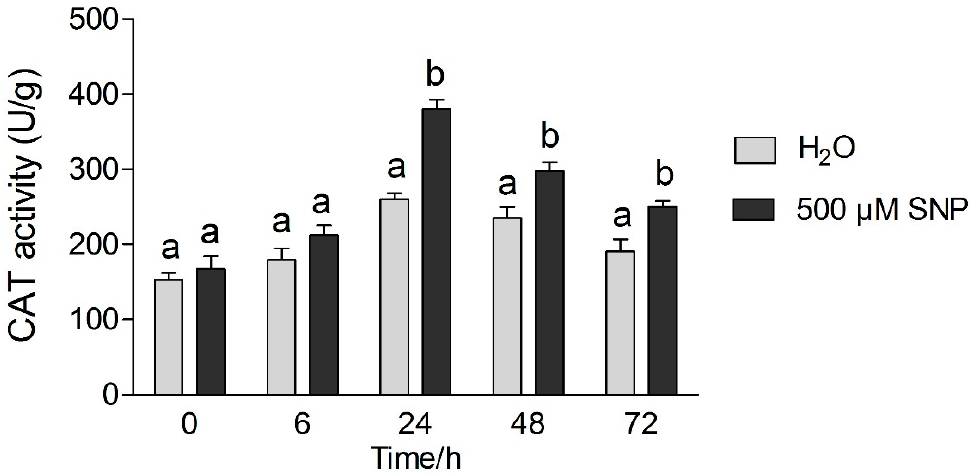
Figure 6. Effect of exogenous nitric oxide on catalase (CAT) activity in tea leaves under cold stress.